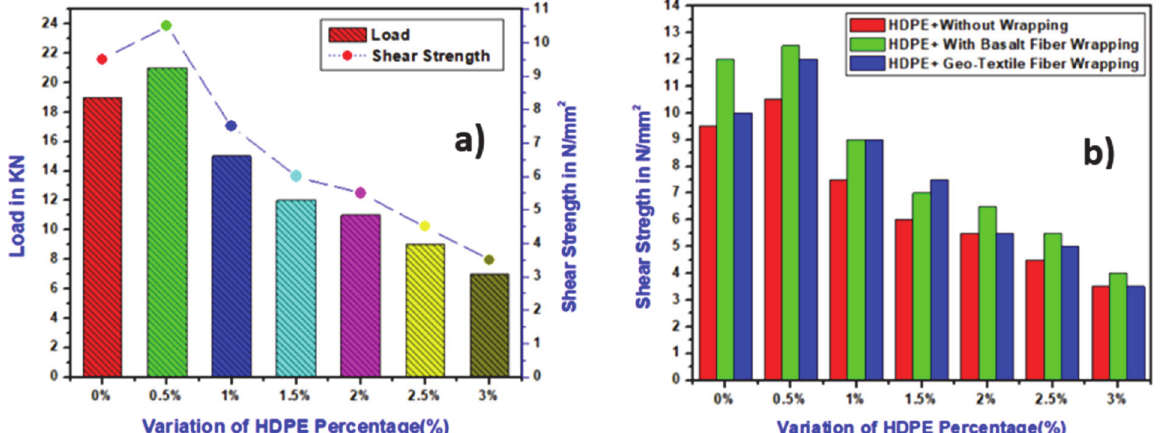
Figure 7: Variation of Shear Strength values in concrete (a) Shear strength versus HDPE proportion (b) shear Strength of fiber wrapped versus HDPE proportion.